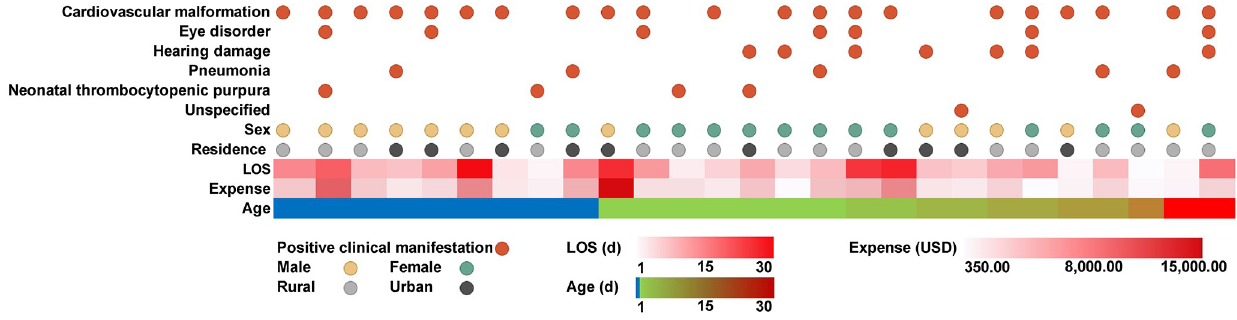
The proportion of children hospitalized with congenital CMV infection was the highest among patients with the four congenital infectious diseases. The male to female ratio was 1.28:1. Neonates accounted for 48.48%, while infant accounted for 51.52% (Table 1). In the cases of neonates, patients with congenital CMV infection have the highest proportion of hos- pitalized patients in Central China (0.18‰, 12/67,524, Fig 1B). However, in the infant group, the highest rate of hospitalization due to congenital CMV infection was in Northwest China (0.39‰, 33/85,275, Fig 1C). The seasonality could not be assessed because monthly case num- bers for congenital CMV infection were rare (S2 Fig).